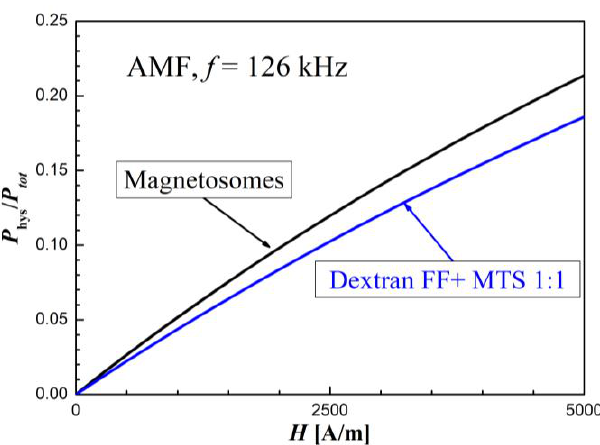
Figure 15. The share of heat energy losses in the magnetosomes sample and in the Dextran FF + MTS sample resulting from magnetic hysteresis in relation to the total loss in a heating effect.